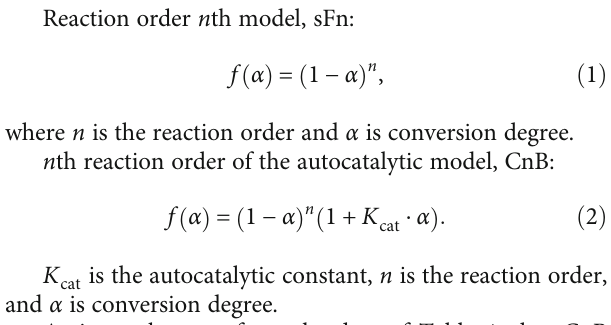
and T with the composition of PEG-plasticized PLA onset 10